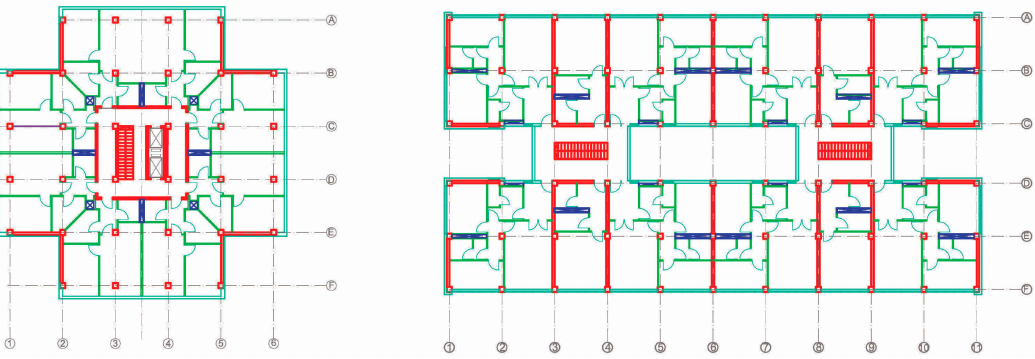
Figure 6. Block No. 1: Tower and condominium buildings—different functional and technical levels are presented by different colors (load-bearing, envelope, partitions and services).